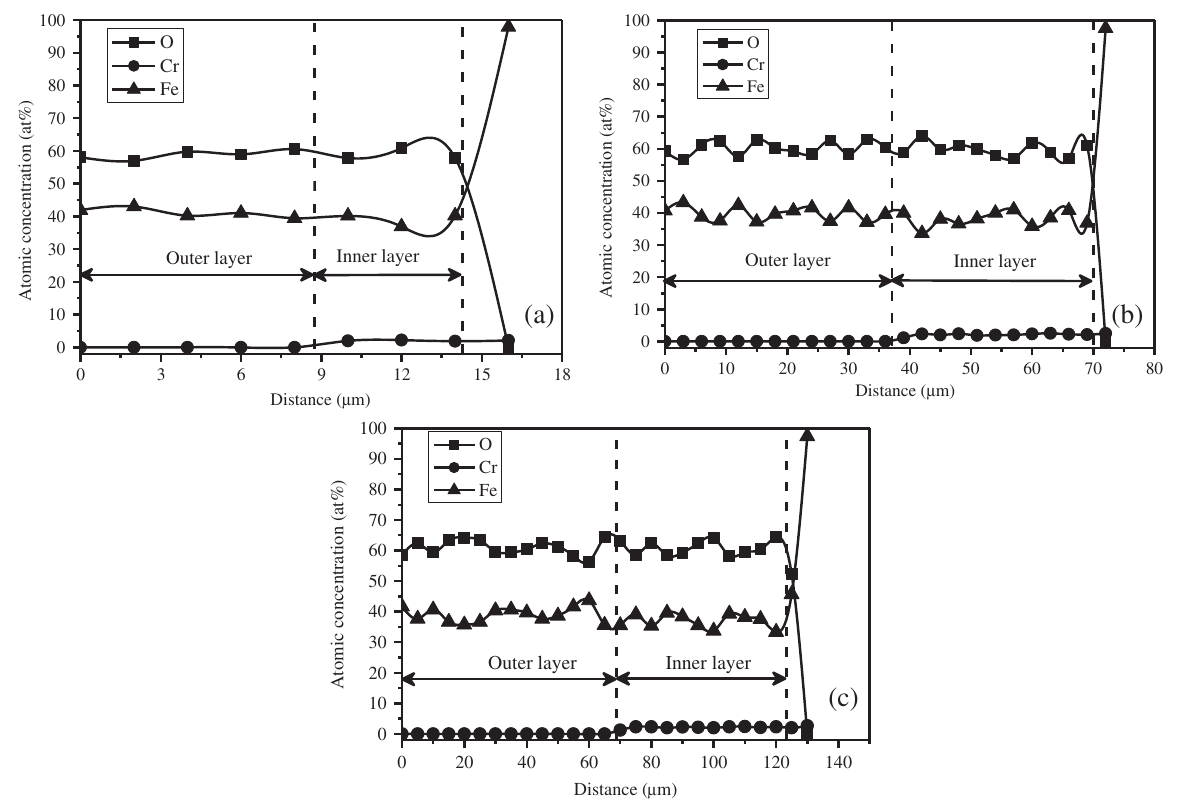
Figure 7: EDS profiles across the oxide layer formed on T22 steel surface exposure to SCW at 620°C and 25 MPa for different time. (a) 10 h, (b) 200 h, (c) 1000